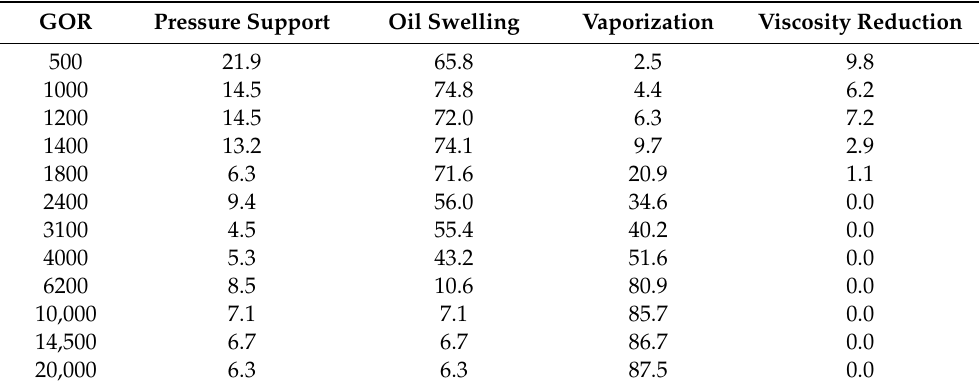
Table 4. Percentage that each mechanism contributes to the recovery due to gas injection.